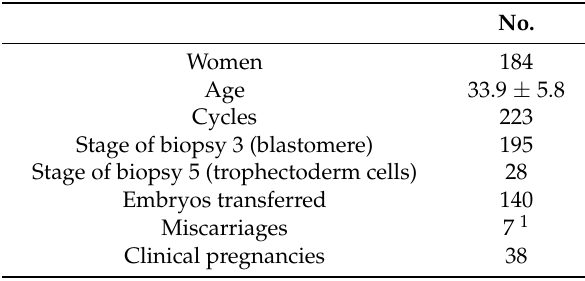
Table 4. Embryo procedures—pre-implantation genetic